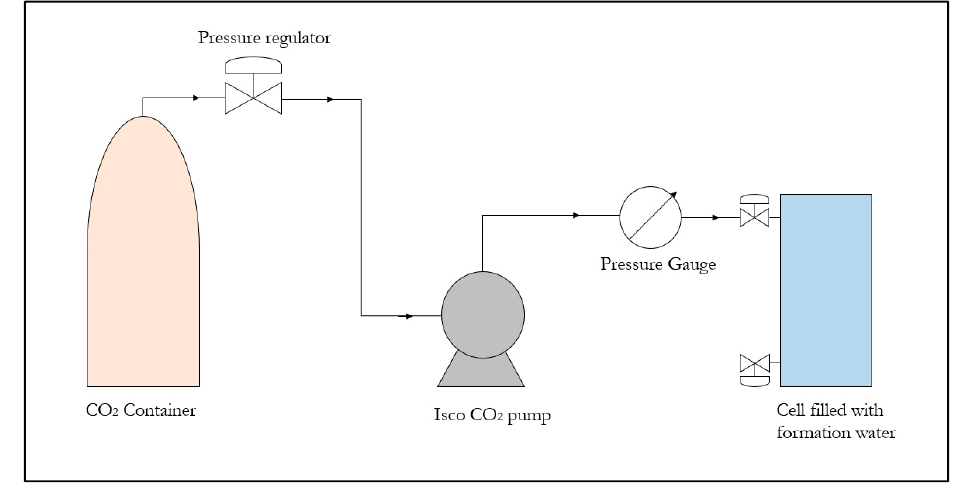
Figure 1 . Schematic of the carbonated water preparation apparatus. Figure 1. Schematic of the carbonated water preparation